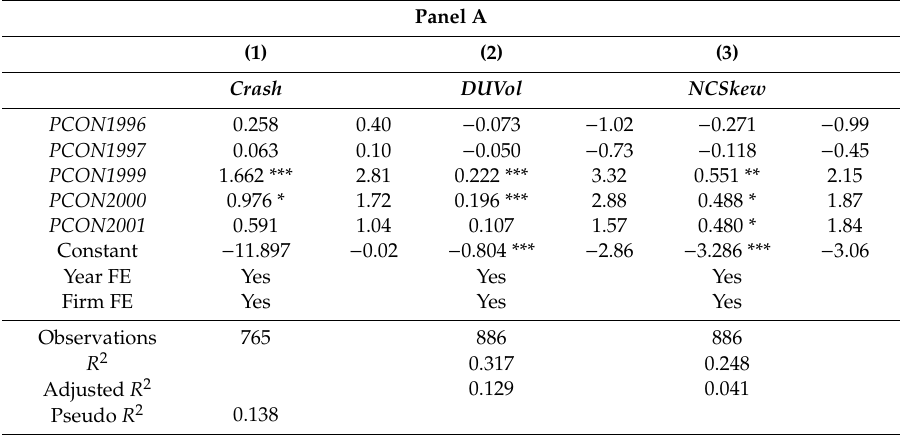
Table 6. Panel A. Test on parallel trend; Panel B. Di ff erence-in-di ff erence